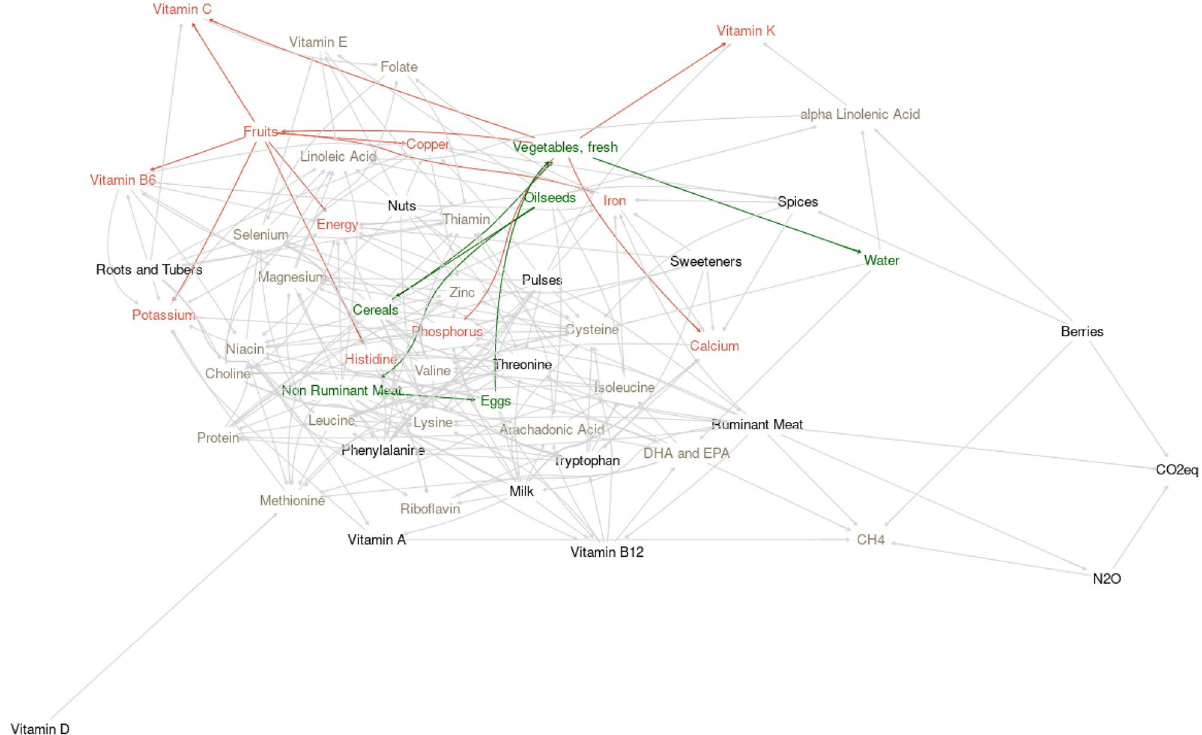
Figure 4. Bayesian learning network relating individual country yearly average production of different categories of foods (total mass produced), production of different nutrients and energy (total amount produced), and agricultural production of methane (CH 4 ), nitrous oxide (N 2 O), and carbon dioxide equivalent (CO 2 eq), and agricultural water use. Nodes are colored to highlight the relationships revealed by exploring the Markov blanket of agricultural water use. Green nodes and edges show conditional dependencies with direct associations driving agricultural water use. Red colored nodes and edges show negative collateral impacts associated with targeting vegetable and fruit production as a strategy for reducing agricultural water use. The variables highlighted in the tan colors show the broader nutrient blanket expected to be conditionally dependent on vegetable and fruit production but through more than 1 degree of drawal, each scaled per capita to avoid skewing by large population countries. Figure 3 highlights the nodes and edges within the network which are associated with targeting strategies to lower per capita CH 4 , N 2 O, or CO 2 equivalents, while Fig. 4 highlights the nodes and edges within the network which are associated with targeting strategies to lower per capita water use. Aside coloring to display key relationships, the networks underlying each figure are identical. The words within each image reflect nodes (i.e., variables) within the network, and arrows reflect conditional dependencies. Arrows are directed implying the node pointed to is conditionally dependent on the node where the arrow originates. Those conditional dependencies also have directionality in terms of the type of association (i.e., inverse versus direct), which are largely codified by the color patterns in each figure. Identified linear relationships and standard errors of associations within the network are presented (Supplemen- tary Table S1). The network revealed a driving role of oilseed production in agricultural systems, highlighted by a cascade of conditional dependencies and positive linear associations where oilseed production drove (directly or indirectly), production of cereals, eggs, sweeteners, non-ruminant meat, vegetables, fruits, pulses, ruminant meat, and milk. Production of nuts, roots and tubers, and berries were largely independent of the oilseed-driven cascade of rela- tionships associating those more prevalent and traditional agricultural products. This was sensible because many industrialized agricultural systems tend to rely on cash crops and production of livestock both to supply domestic demand and to support economically viable trade. Nuts, roots and tubers, and berries require more specialized environmental conditions and are likely more driven by climate than by other agricultural system factors. Assessment of greenhouse gas nodes revealed conditional dependencies on berries and ruminant meat. Meth- ane was additionally conditionally dependent on DHA + EPA and vitamin A supplies within systems. Associations among greenhouse gas variables and berries were inverse, suggesting those systems with greater berry production per capita tended to have lower greenhouse gas emissions. The other associations were direct, suggesting that with greater production of ruminant meat, and provision of DHA + EPA and vitamin A came greater production of greenhouse gases. Ruminant meat was highly central within the network and was tightly linked with milk production. To explore the impacts of reducing ruminant meat and milk production as a strategy to control greenhouse gas emissions, we explored the directionality of conditional dependencies relating nutrient provision to supplies of meat. Twelve nutrients were directly associated with ruminant meat and milk production, while